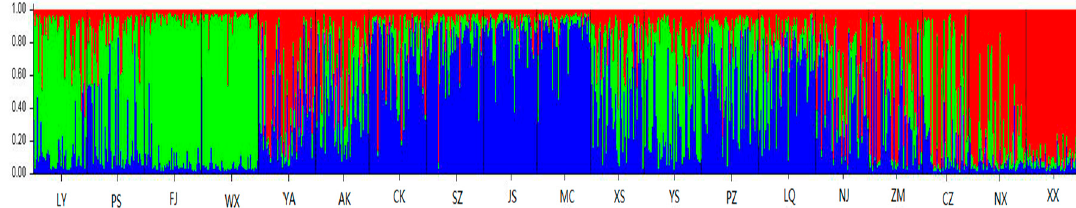
Figure 4. Results of the structure analysis of Q. variabilis populations when K = 3. Each individual is represented by a single vertical bar, which is partitioned into three different colors. Each color represents a genetic cluster and the colored segments shows the individual’s estimated ancestry proportion to each of the genetic clusters. The population codes are as in Table 1.